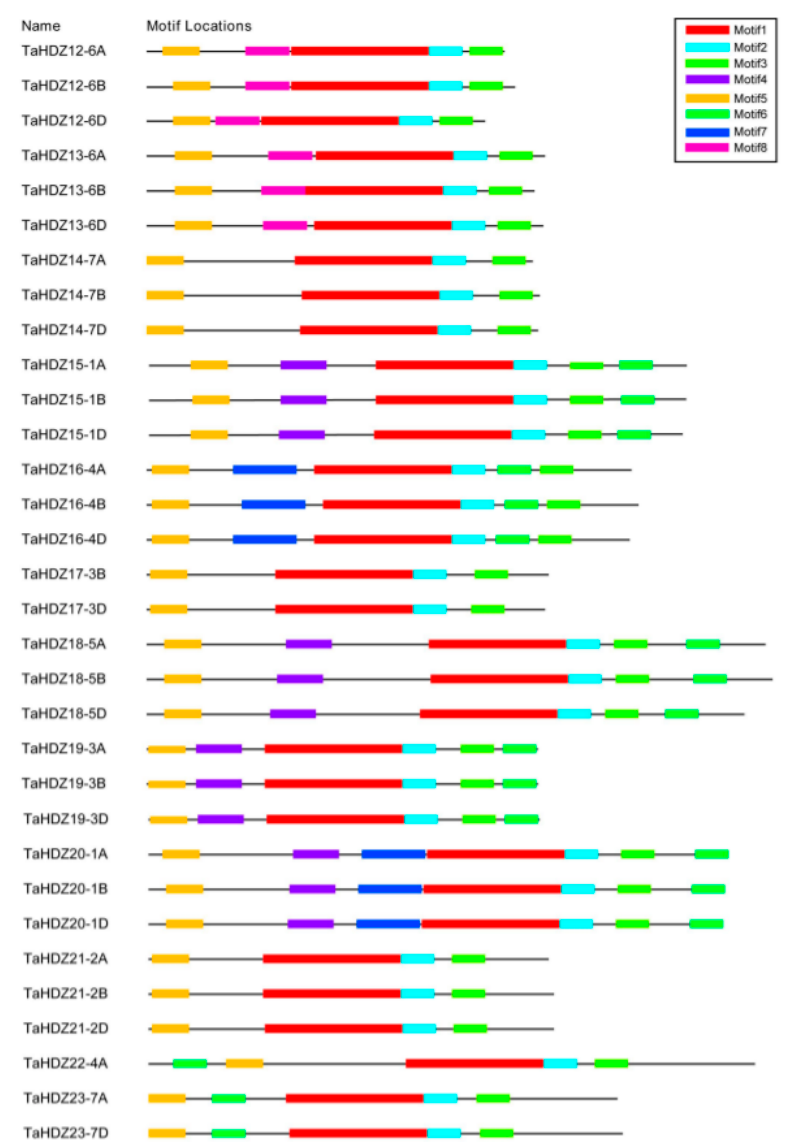
Figure 7. Putative motifs of the wheat HD-ZIP II subfamily proteins using the MEME program. The different conserved motifs are marked by different colors.